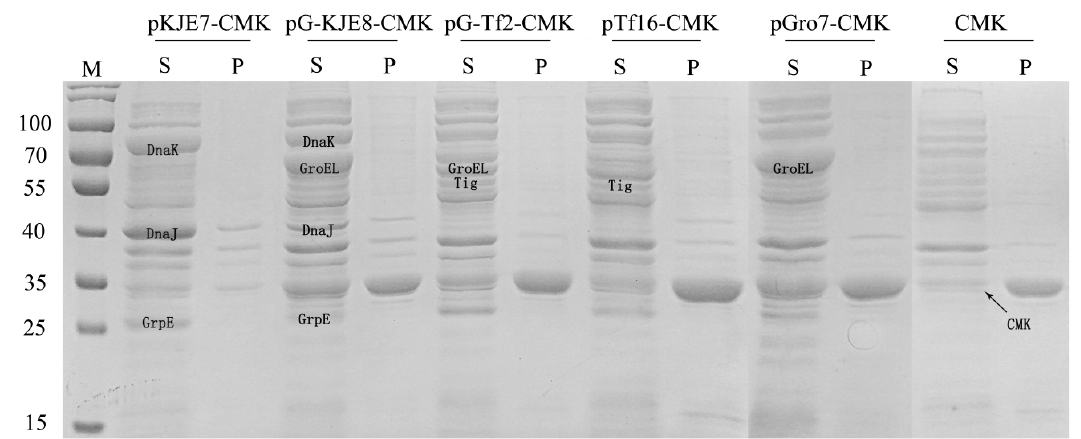
Figure 3. SDS-PAGE of CMK co-expression with various chaperones. Lane S denotes supernatant of the cell-extracts, lane P denotes precipitation fraction of the cell-extracts; lane M shows molecular weight markers.